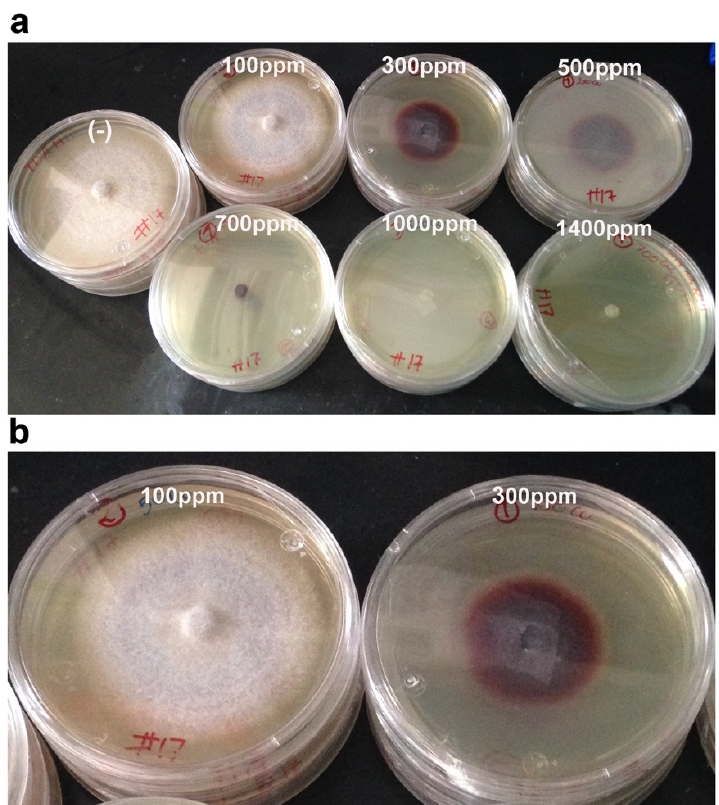
Figure 3. Growth of strain H17 in PDA with di ff erent Cu concentrations. ( a ) Copper concentrations tested for strain H17, a purplish pigment is produced as the Cu ppm increases, until no growth is achieved (1000 ppm). ( b ) A comparison between strain H17 grown in 100 ppm vs. growth in 300 ppm to stress the pigmentation in response to Cu. The picture was taken after 8 days of incubation at 28 ◦ C. Table 2. Growth and percentage inhibition values for strain H21 in di ff erent metal concentrations. Strain